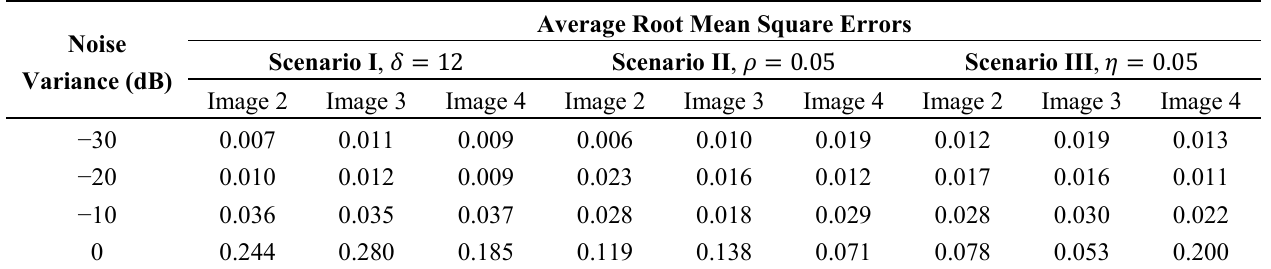
Table 6. The residual registration errors for various noise variances and (cid:2010) (cid:3404) 0.75. Noise